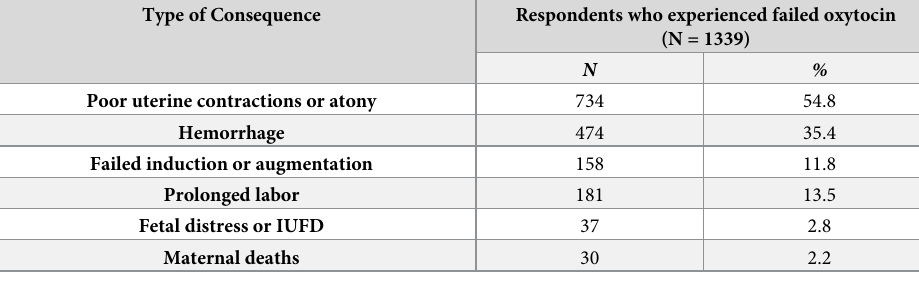
Table 7. Respondents’ � who experienced failed oxytocin by type of consequences.